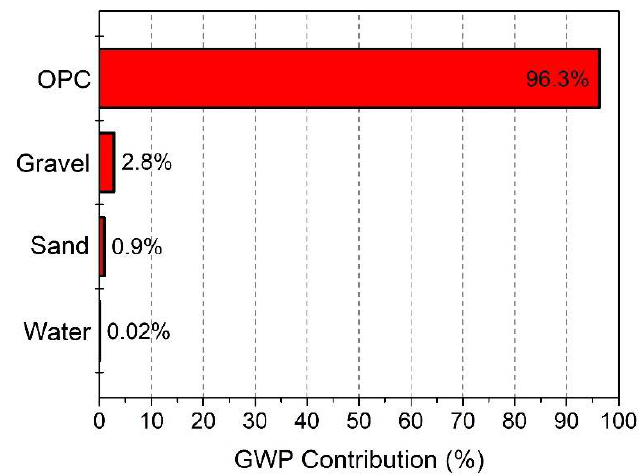
Figure 17. Percentage contribution of raw materials to the GWP of the alkali-activated hybrid concrete (90% FA–10% OPC).